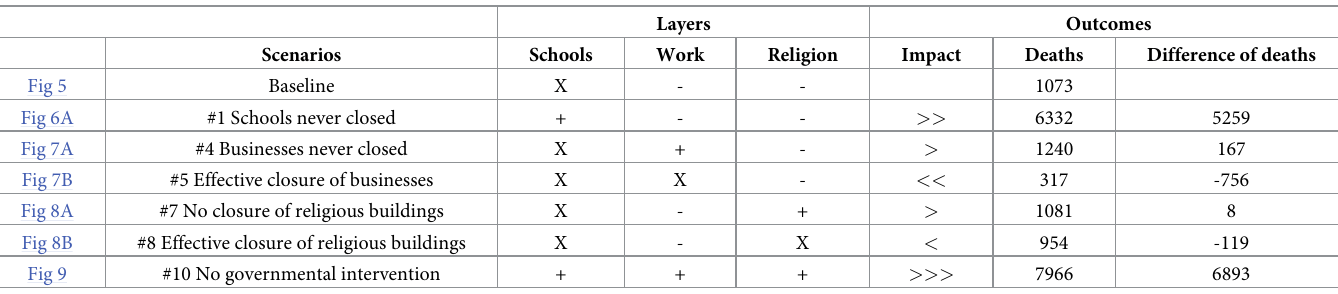
Table 5. Summary of simulation